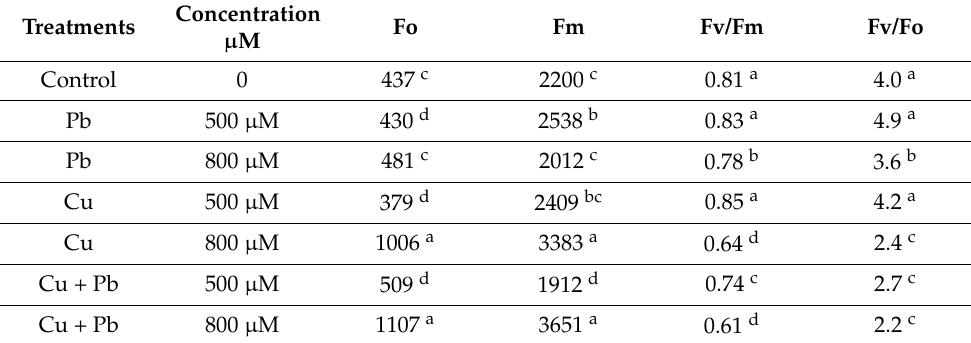
Table 3. Effects of Cu(SO 4 ) 2 and Pb(NO 3 ) 2 on chlorophyll fluorescence parameters (Fo, Fm, Fv/Fm, Fv/Fo) of Citrus aurantium L. (Nine replications, plants). Quality characteristics are the mean of five measurements. Means in the same column followed by different letters are significantly different ( p ≤